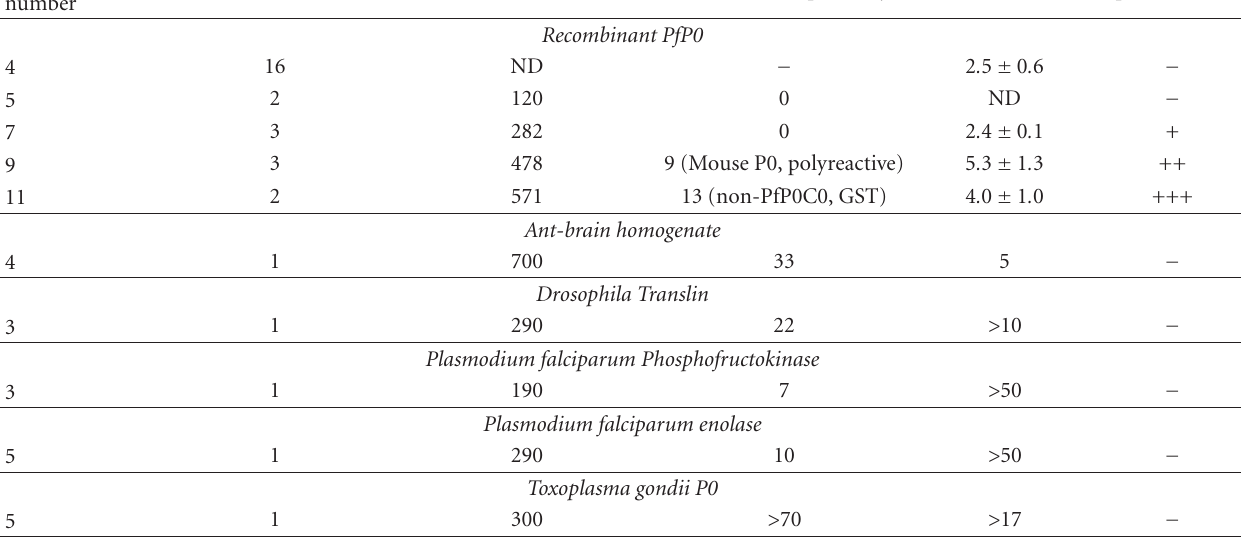
Table 2: Serum titre and hybridomas obtained following repeated immunizations with various proteins. Immunization